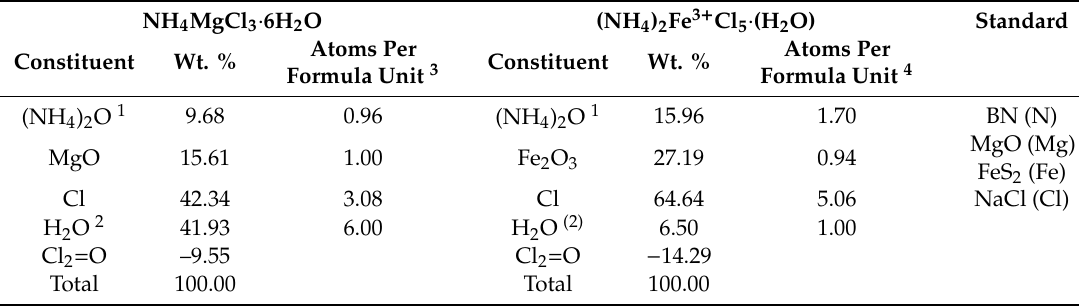
Table 3. Chemical composition of NH 4 MgCl 3 · 6H 2 O and (NH 4 ) 2 Fe 3 + Cl 5 · H 2